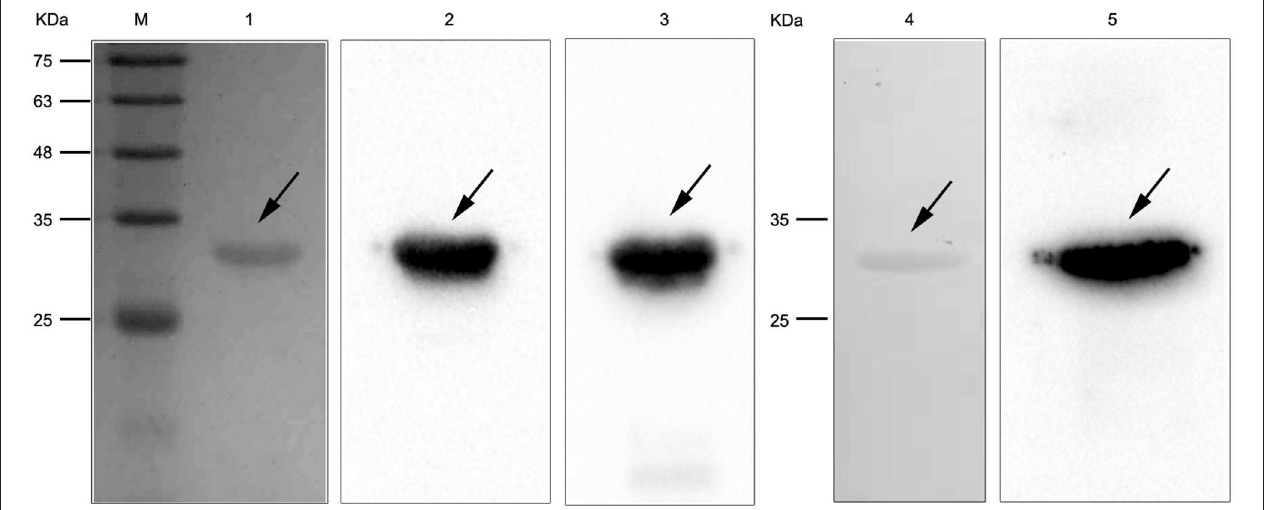
FIGURE 2 | SDS-PAGE and western blotting of Nocardia cyriacigeorgica heparin-binding hemagglutinin HBHA protein. Lane M: protein marker. Lane 1: Purified HBHA protein. Lane 2: HBHA protein was detected with anti-HBHA sera. Lane 3: HBHA protein was detected with anti-His sera. Lane 4: Purified truncated HBHA protein. Lane 5: Truncated HBHA protein was detected with anti-HBHA